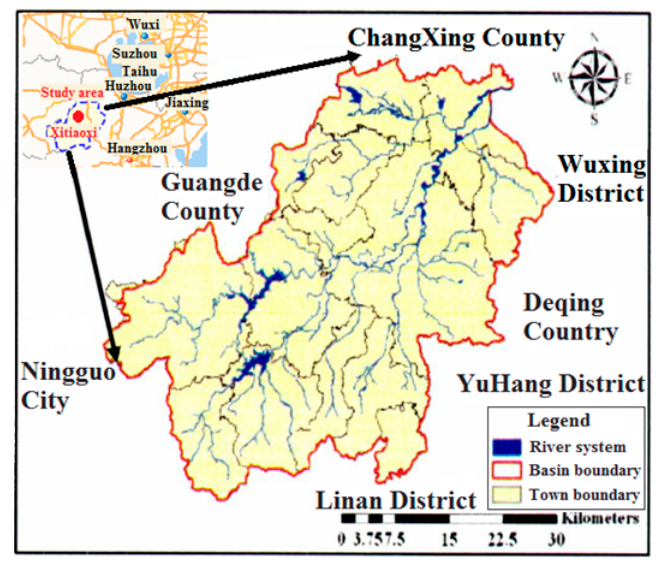
Figure 2. Overview of the study area.